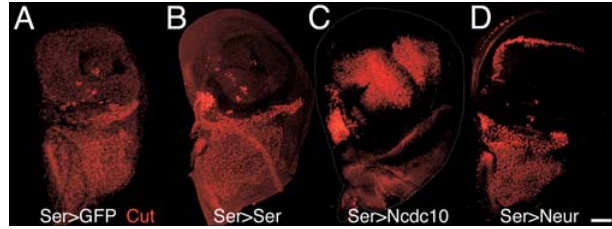
Figure 8. Expression of Neur in Dorsal Cells Is Sufficient to Rescue the D- mib Mutant Phenotype D-mib 2 / D-mib 3 mutant discs expressing GFP (A) (GFP staining not shown), Ser (B), Ncdc10 (C), or Neur (D) under the control of Ser- GAL4 were stained for Cut (red). Expression of Ser in dorsal cells did not rescue the D-mib 2 / D-mib 3 wing pouch mutant phenotype (compare [B] with [A]), consistent with D-mib being required for Ser signaling. By contrast, expression of Ncdc10, an activated version of N, led to the deregulated growth of the dorsal compartment and the expression of Cut in most dorsal cells (C), indicating that activated N acts downstream of D-mib . Expression of Neur in dorsal cells was sufficient to compensate for the loss of D-mib activity (D). Bar is 40 l m for all panels. DOI: